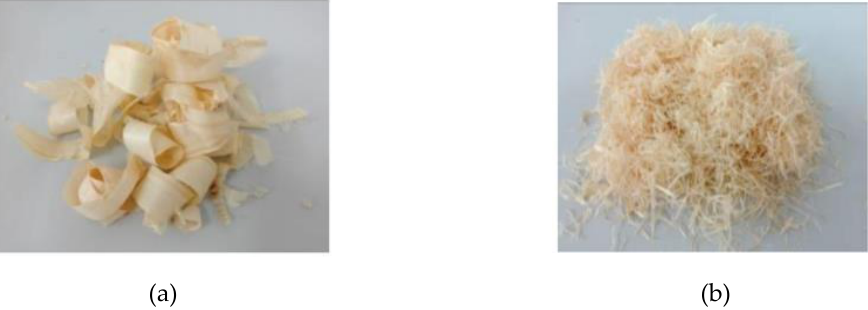
Figure 7. Wood fiber: ( a ) after being cut along; ( b ) micro wood fiber following heat treatment.